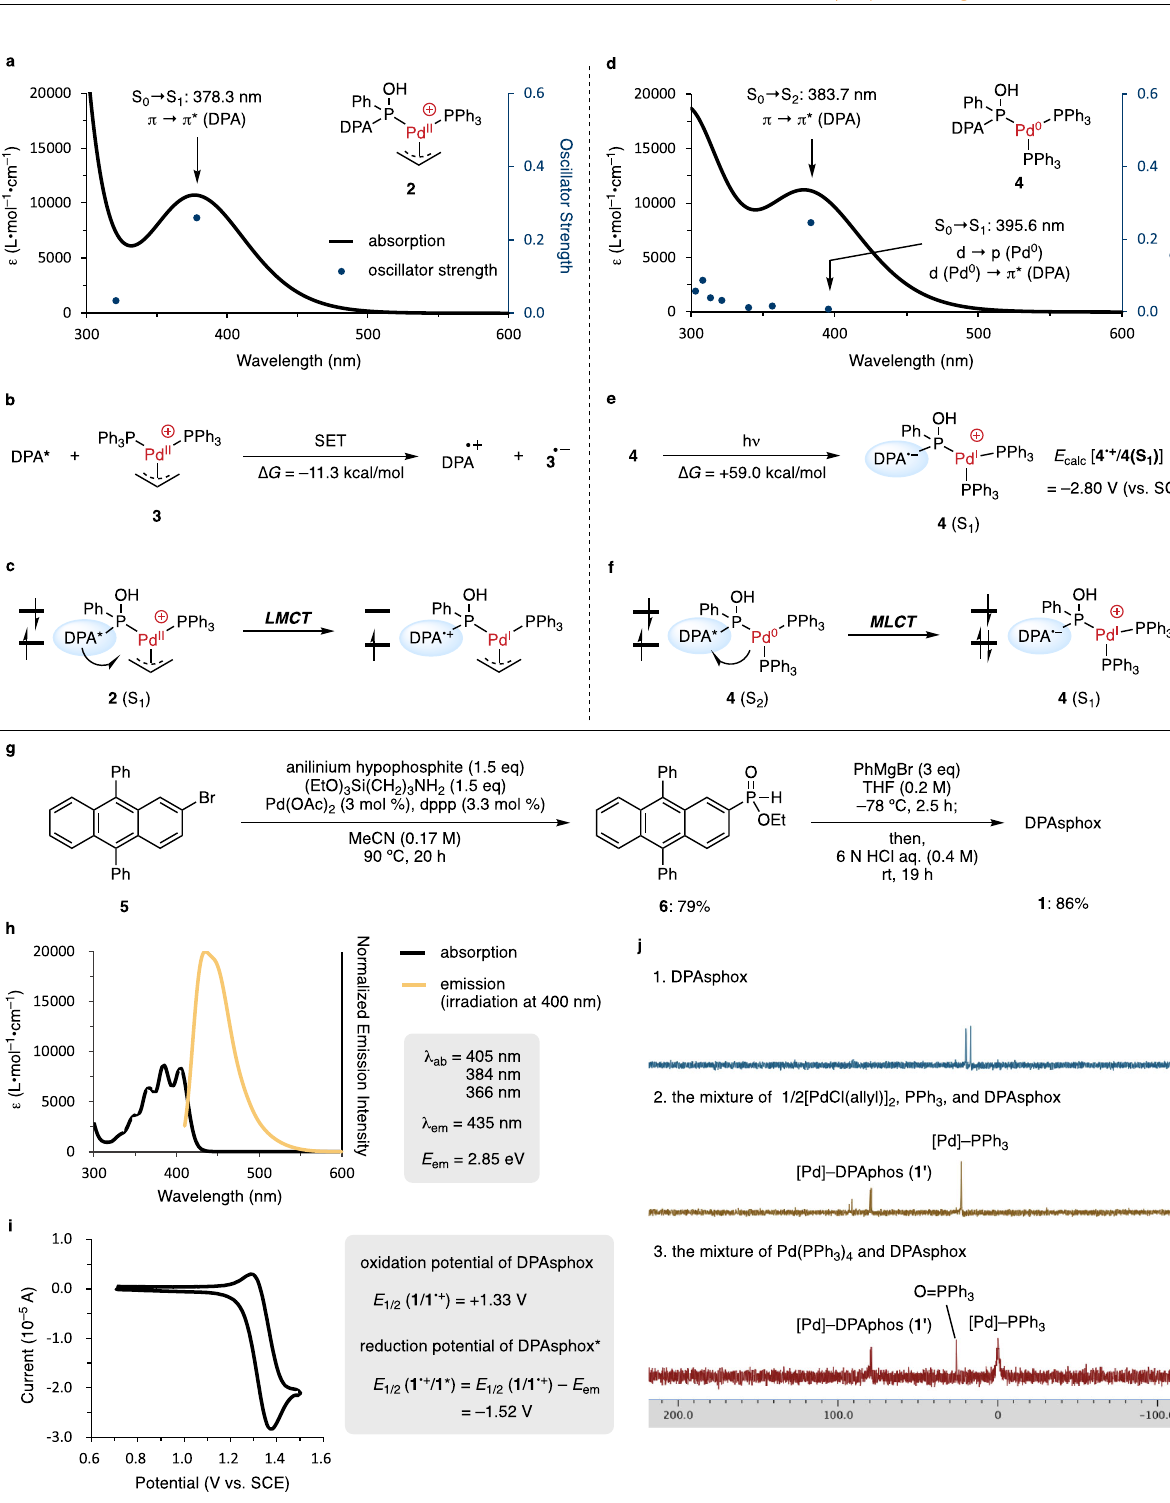
Fig. 2 Calculated excited states of Pd-DPAphos complexes and synthesis of DPAsphox (1). a UV-Vis spectrum of Pd(II) complex ( 2 ) calculated with ω B97X-D/SDD, 6-311 + G(d,p)//MN15/SDD, 6-31 G(d) in DMF (PCM). b Intermolecular SET from DPA* to Pd(II) complex ( 3 ) is a thermodynamically favored pathway. c LMCT after π → π * transition on complex 2 produces Pd(I) and DPA (cid:129) + . d UV-Vis spectrum of Pd(0) complex ( 4 ) calculated with ω B97X-D/SDD, 6-311 + G(d,p)//MN15/SDD, 6-31 G(d) in DMA (PCM). e Calculation of the fi rst singlet excited state of 4 . f MLCT after π → π * transition on complex 4 produces Pd(I) and DPA (cid:129) − . g Synthesis of DPAsphox. h UV-Vis spectra of DPAsphox in DMF. i Cyclic voltammogram and redox potential of DPAsphox. j 31 P NMR studies of the mixture of Pd(0 or II) complex and DPAsphox. DPA 9,10-diphenylanthracene, SET single electron transfer, LMCT ligand-to-metal charge transfer, MLCT metal-to-ligand charge transfer, dppp 1,3-Bis(diphenylphosphino)propane, THF tetrahydrofuran, SCE saturated calomel